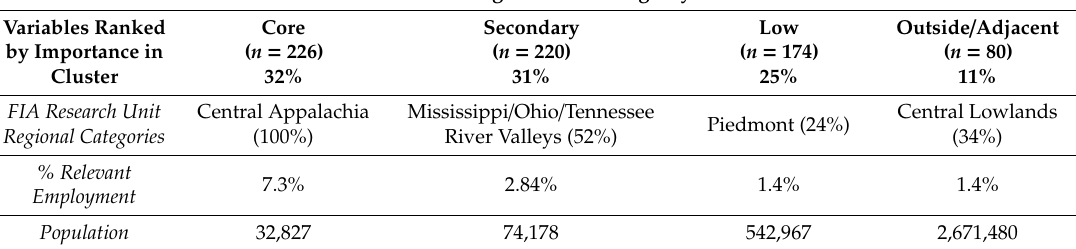
Table 4. Registered ginseng dealers licensed in 15 eastern states grouped into four clusters using two-step cluster analysis. The most common (categorical) and mean (continuous) values used to create each cluster are presented.